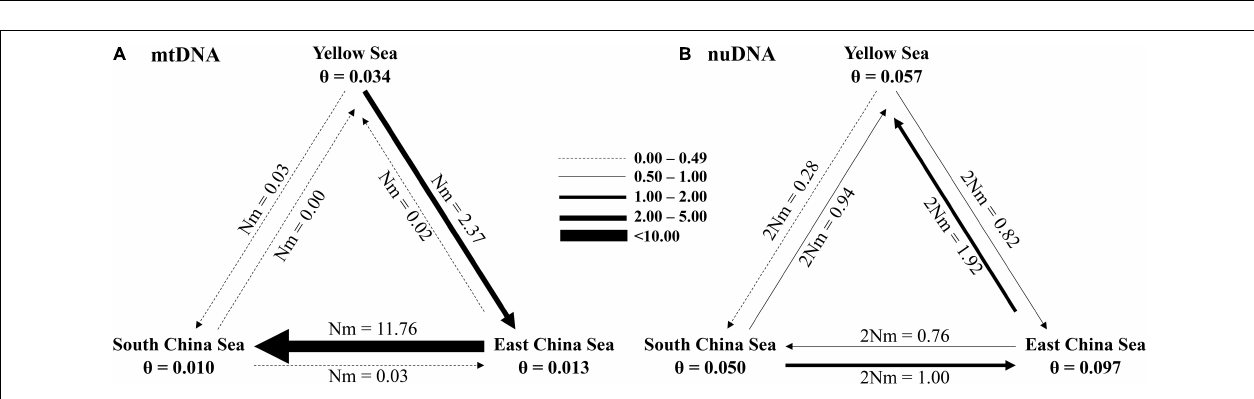
FIGURE 7 | Graphic representation of the three scenarios, (A) mtDNA phylogenetic model, (B) nuDNA phylogenetic model, and (C) combination model, used in the ABC analyses. The t -values correspond to the timing of past divergence events or past admixture between populations. Note that time is not to scale. (D) Relative posterior probabilities for each scenario and their 95% highest posterior density interval (HPDI) based on the logistic estimate by DIYABC.